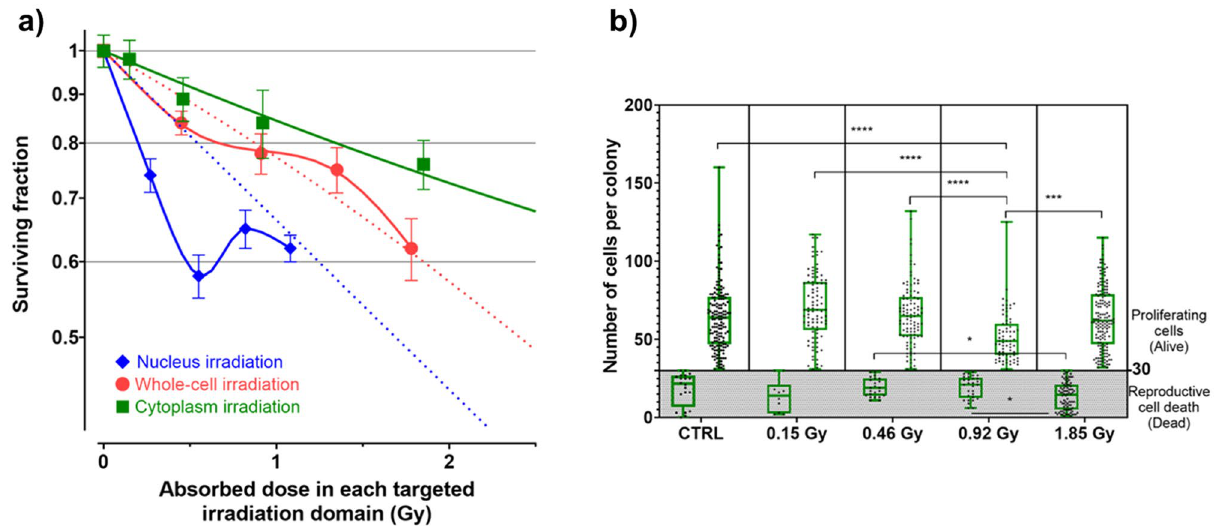
Figure 2. Surviving fraction of V79 cells irradiated with differently sized synchrotron radiation X-ray microbeams. ( a ) Surviving fractions of V79 cells irradiated with a 50 × 50 µm X-ray beam with the X-ray mask (filled squares; cytoplasm irradiation) were plotted as a function of the absorbed dose in the cytoplasm. Standard errors were calculated using Eq. (4). The total number of colonies counted (N in Eq. 4) was 181, 100, 125, 100, 245 at 0 Gy (non-irradiated control), 0.15 Gy, 0.46 Gy, 0.92 Gy, and 1.9 Gy irradiation, respectively. Surviving fractions of V79 cells irradiated with 10 × 10 µm (filled diamonds; nucleus irradiation) and 50 × 50 µm (filled circles; whole-cell irradiation) X-ray beams were obtained from our previous work 13 . Each data point represents the mean of at least three independent experiments. Dotted lines show the linear-quadratic fitting based on data for higher radiation doses. p-values of cytoplasmic irradiation are shown in Supplementary Table S1 online, and the R 2 of survival curve of cytoplasmic irradiation was 0.9930. ( b ) The distributions of the number of cells per colony in the nonirradiated control (CTRL) and cytoplasm-irradiated cell groups are shown by box-and-whisker plots with individual data points. Colonies with more than 30 cells per colony after 60 h of irradiation were considered viable. The boxes indicate the 25th–75th percentile, the line in the boxes indicates the median, and the whiskers indicate the range (minimum to maximum) of the data. p-values ( ns not significant, *p < 0.05, **p < 0.01, ***p < 0.001, ****p < 0.0001) calculated with Tukey’s multiple comparison test. p-values for each comparison pair are also shown in Supplementary Table S2